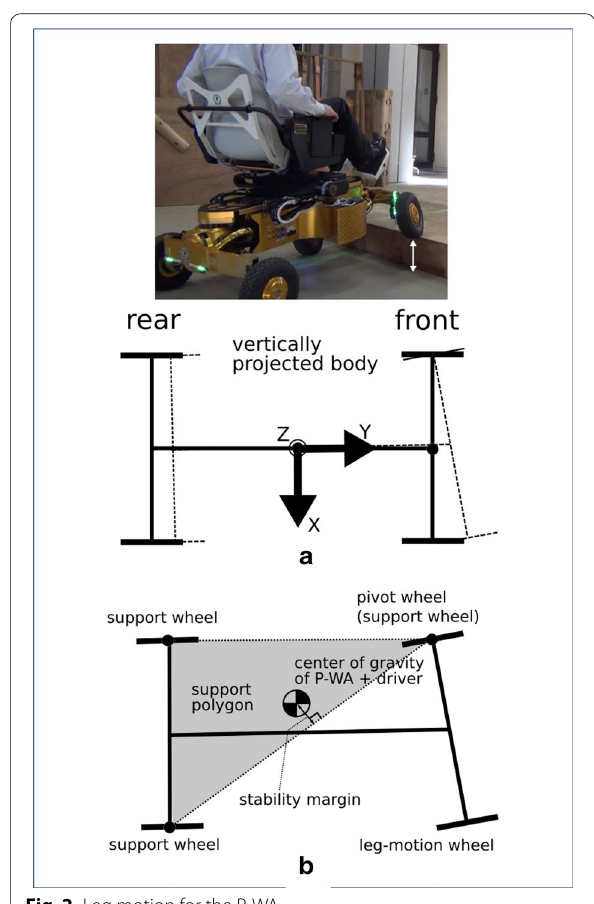
Fig. 2 Leg motion for the P-WA